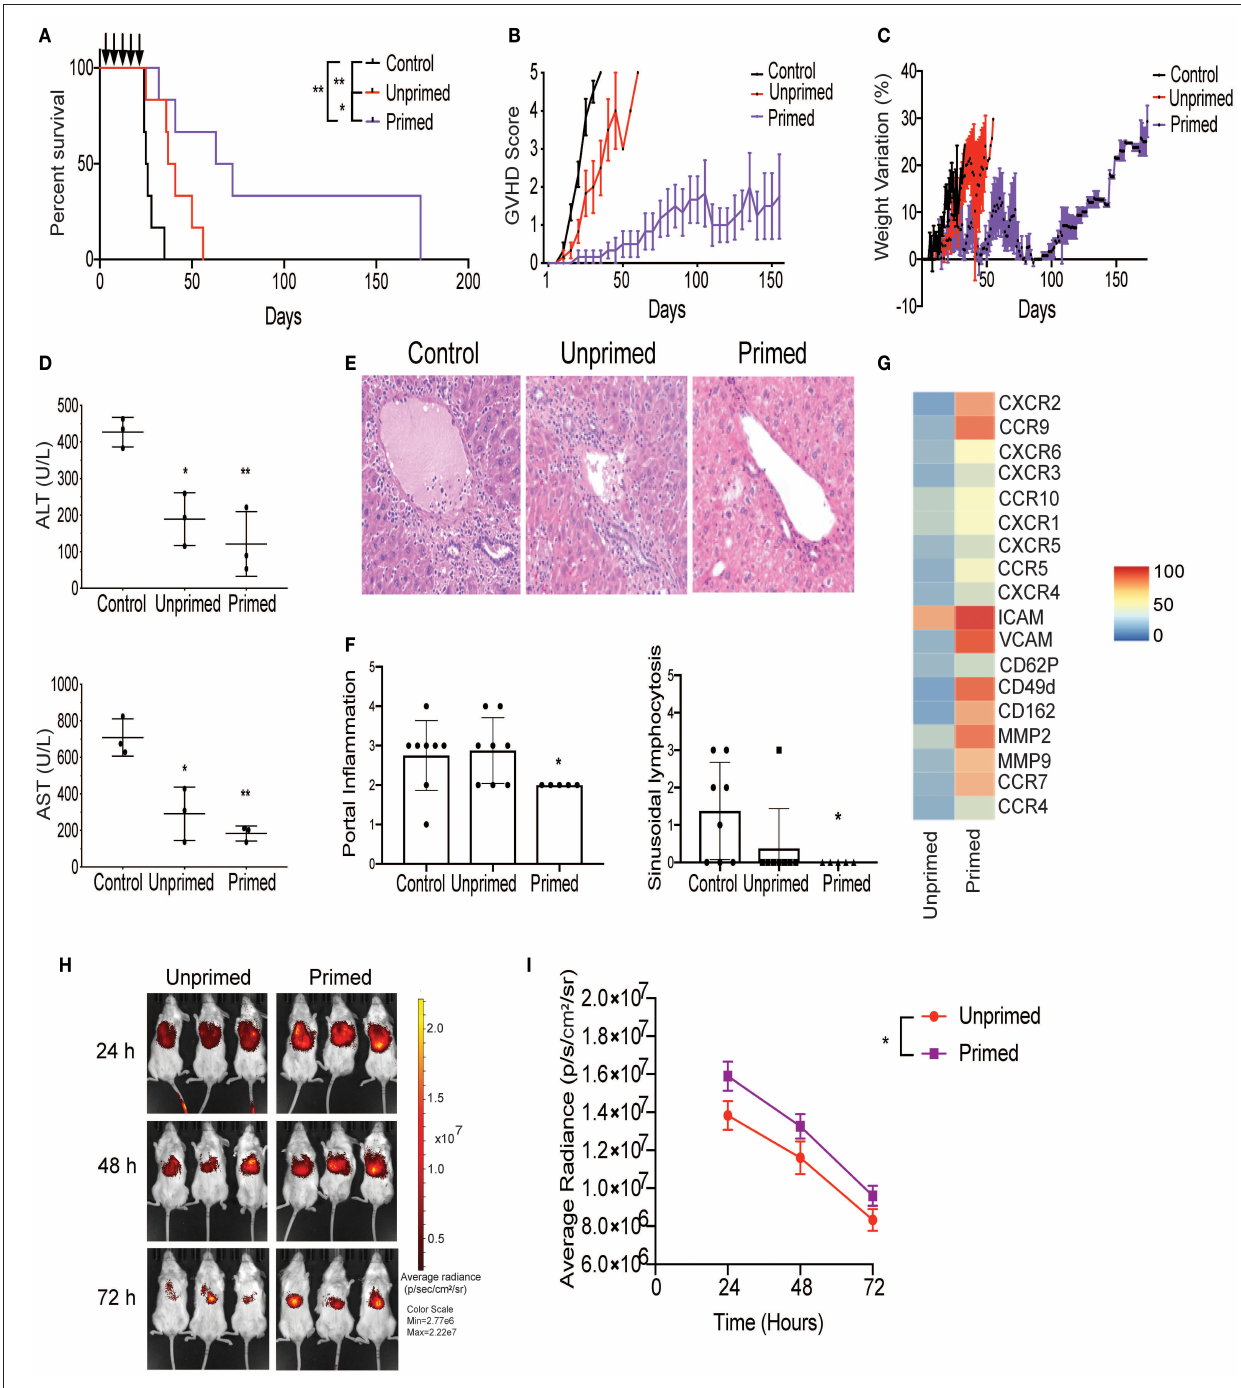
FIGURE 4 | Primed CBti MSC improve outcome in a xenograft mouse model of GVHD. Impact of CBti MSC therapy in a xenograft mouse model of GVHD comparing survival curve (A) , evolution of clinical scores (B) , and weight loss (C) over time for each group of recipient mice receiving PBS (control mice, black line), mice injected with unprimed CBti MSCs (red line), or mice injected with primed CBti MSCs (purple line). Statistical significance is indicated as * p ≤ 0.05, ** p ≤ 0.01 ( n = 6 per group). Arrows indicate the days of injection. (D) Plot of AST and ALT levels determined in the serum of mice at day 29 ( n = 3). Statistical significance is indicated as * p ≤ 0.05, ** p ≤ 0.01. (E) Representative images of livers for each group. Magnification 20X. (F) Plot of the quantitative analysis of liver histological changes. The grade of inflammation was determined for each animal at the end time point. (G) Heatmap of the surface expression of key chemokine receptors and adhesion molecules involved in the homing of MSC analyzed by flow cytometry. (H) Biodistribution of DiR-labeled unprimed (red) and primed (purple) CBtiMSC over 72h after intravenously injection in a xenograft GVHD mice model. (I) Plot of cumulative data for radiant efficiencies in the total body. Paired t -test was performed and statistical significance is indicated as * p ≤